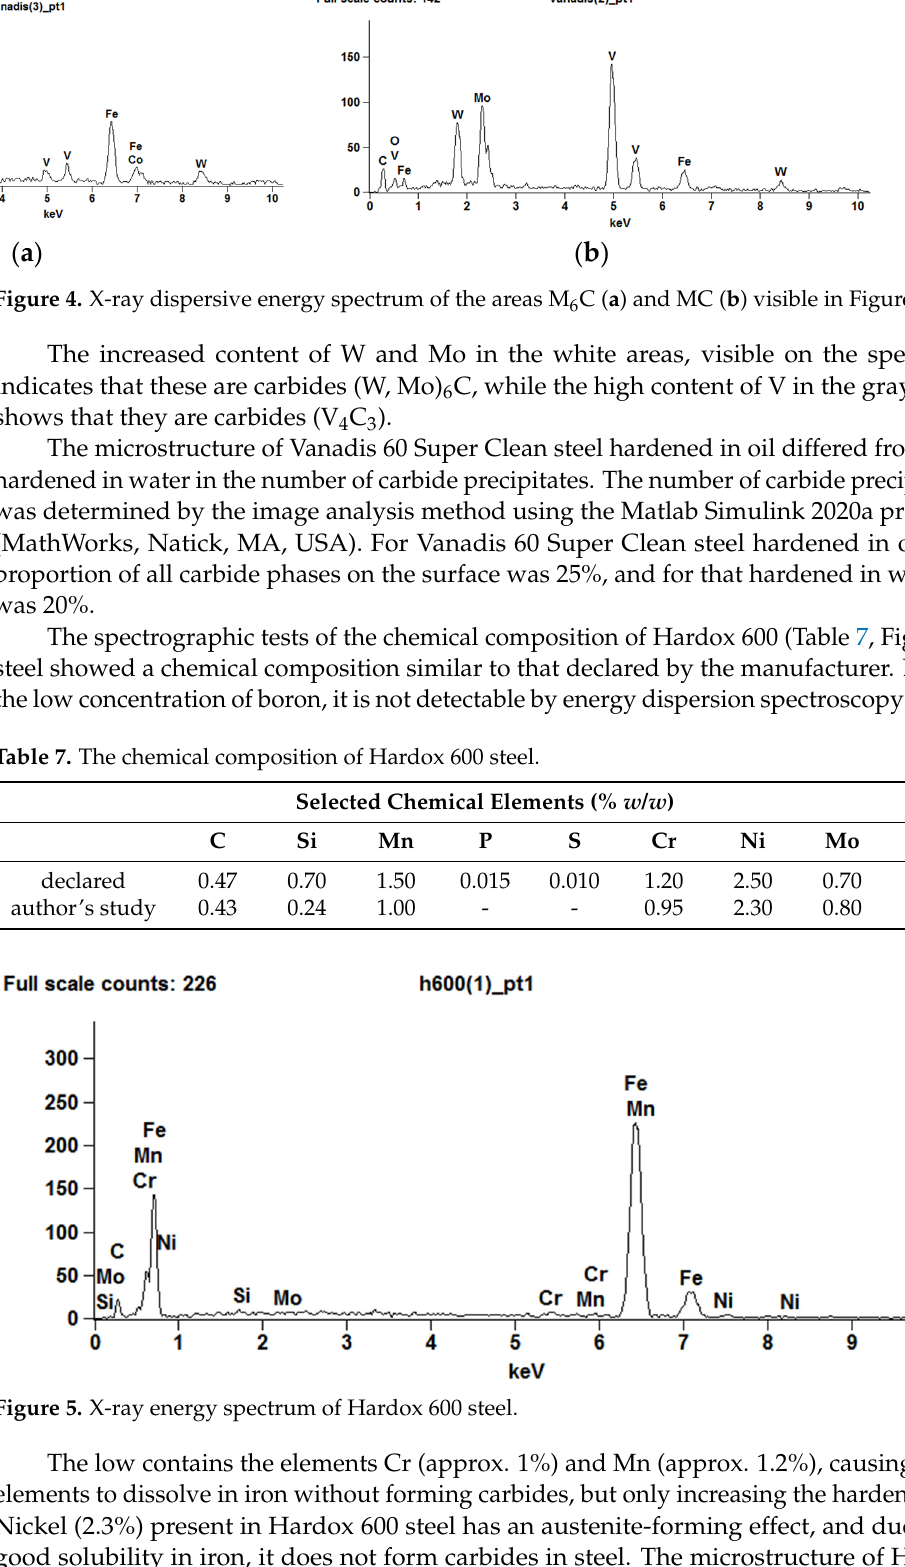
Figure 3. The microstructure of Vanadis 60 SuperClean steel hardened in oil ( a ) and in water ( b ). It was etched with Nital 5%. Scanning electron microscopy.